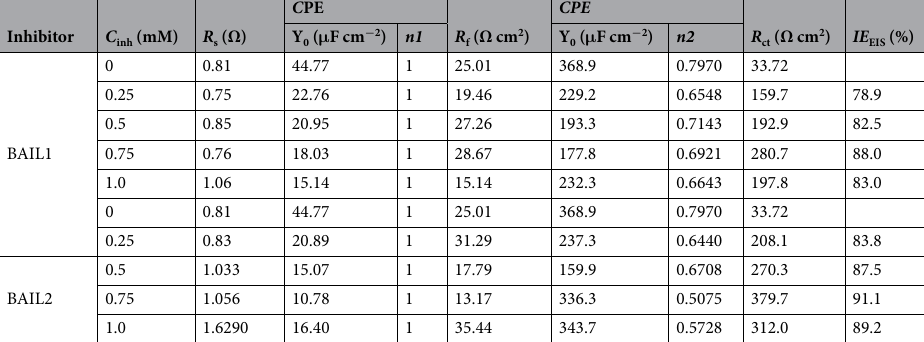
phase element is often used to replace the double layer capacitance ( C dl ) to give a more accurate fit 24 . CPE 1 and CPE 2 are constant phase elements correspond to the capacitance of the film formed on the electrode surface and the double layer capacitance at the interface between the steel and solution in the film pores. The impedance function of the CPE can be expressed as follows 25 .